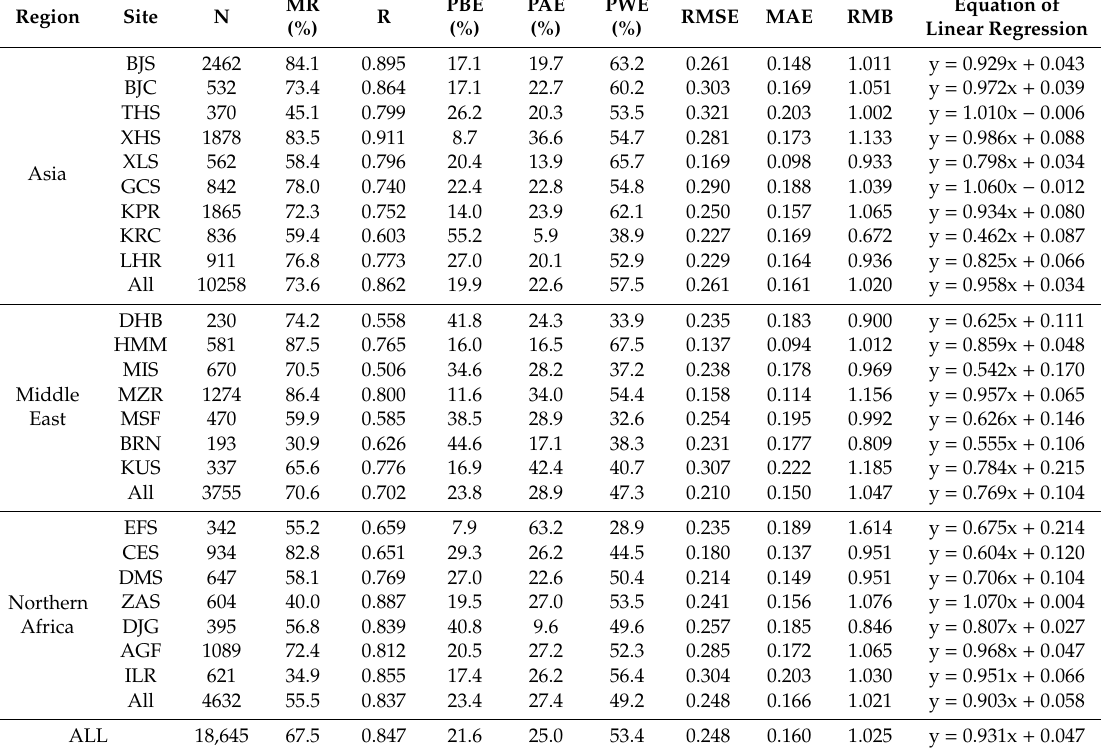
Table 3. Statistical summary for validation of MOD04 DB AOD